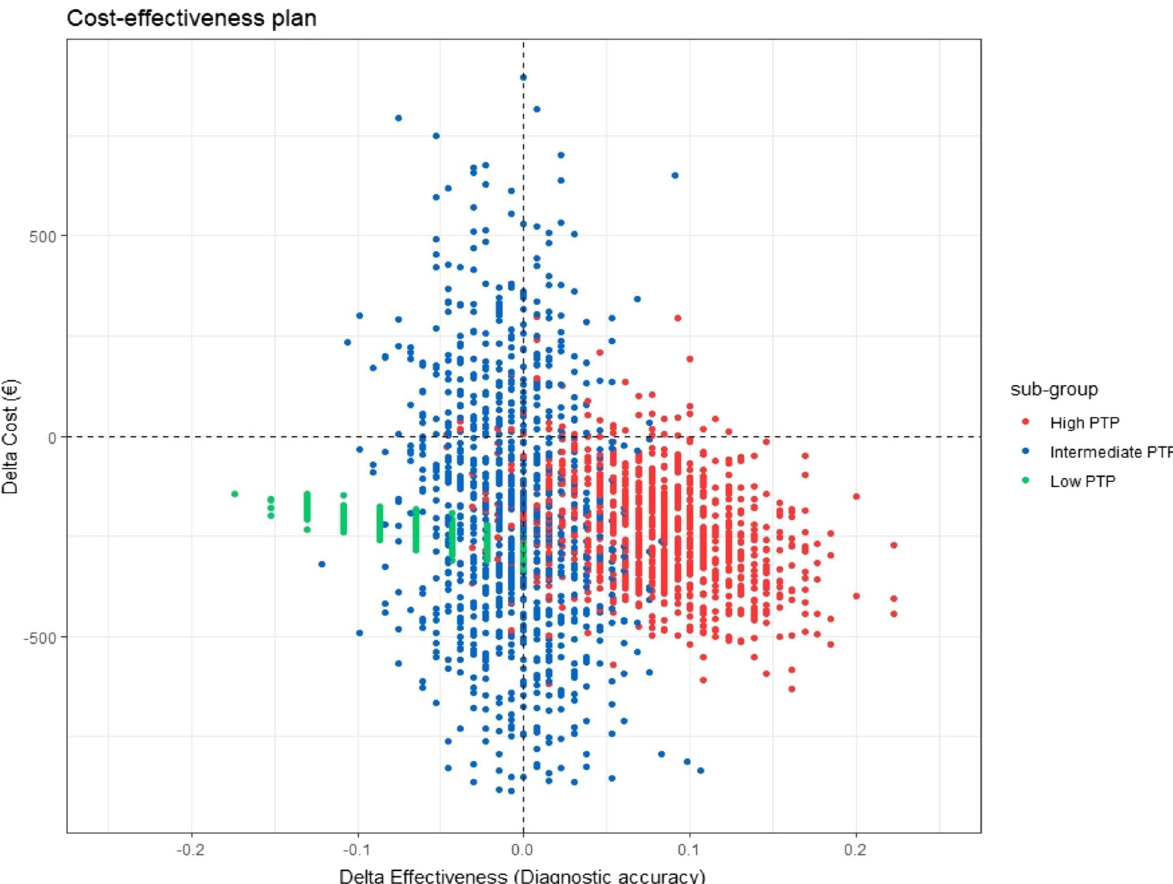
Fig. 3 Cost‑effectiveness plane: Incremental Cost‑Effectiveness Ratio of Costs per additional accurate diagnosis at 12 months in each